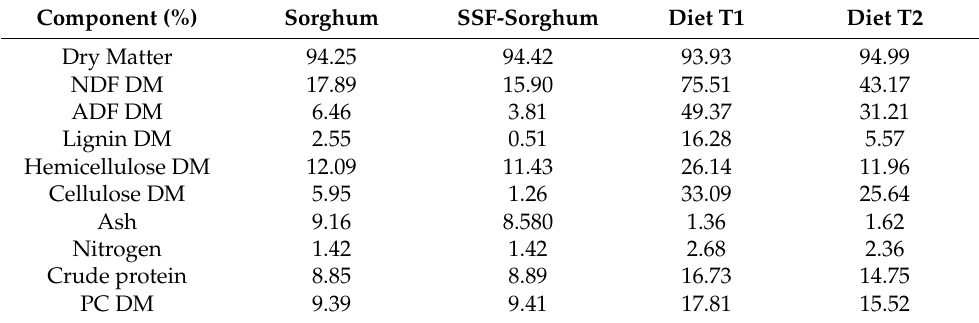
Table 2. Composition of the fiber fraction of untreated sorghum (control) and sorghum transformed by SSF with T. maxima CU1 and P. sanguineus CS2, and of the diets based on both substrates. Component (%) Sorghum SSF-Sorghum Diet T1 Diet T2 Dry